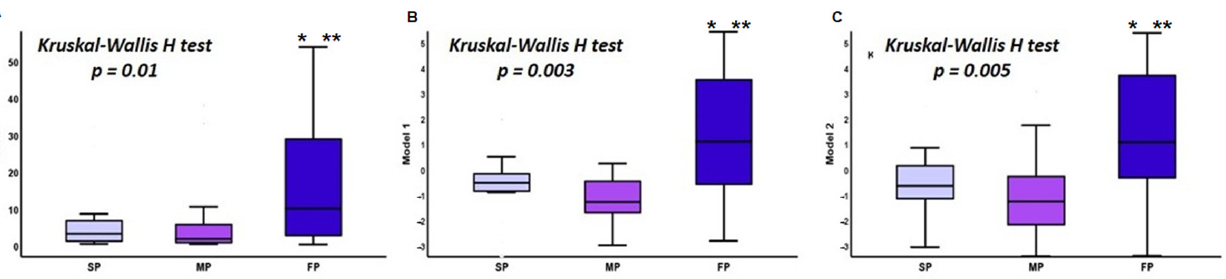
Figure 3. Differences in serum levels of let-7b ( A ), Model 1 ( B ), and Model 2 ( C ) between SP, MP and FP. * p < 0.001 (FP vs. SP), ** p < 0.01 (FP vs. MP). SP: Slow Progressors, MP: Moderate Progressors, FP: Fast